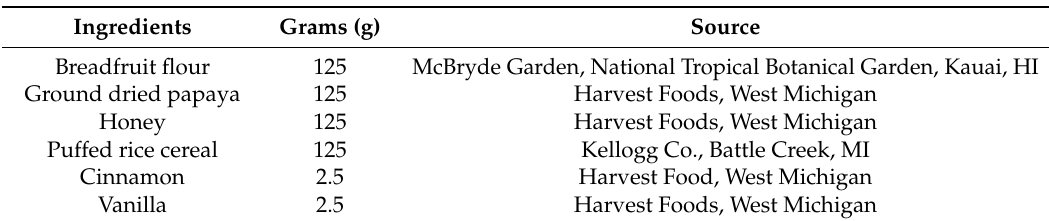
Table 1. Breadfruit bar ( Meinpadahk )